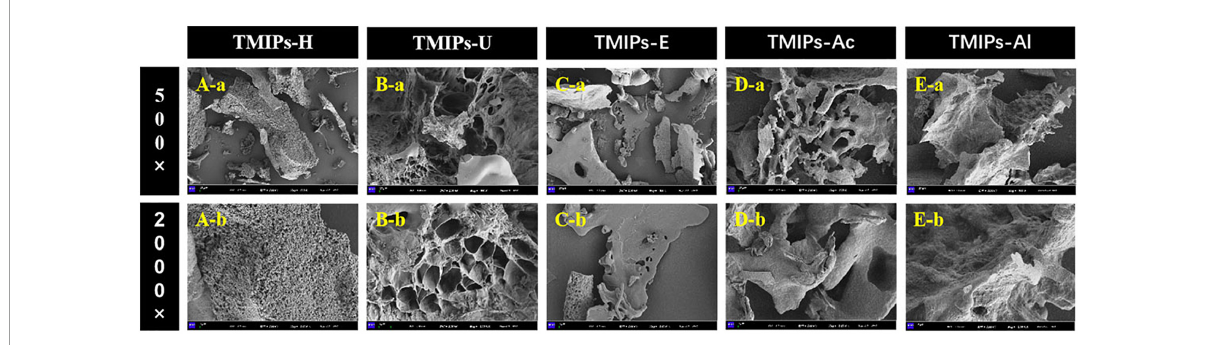
FIGURE5 Scanning electron microscopy (SEM) micrographs of TMIPs. (A) TMIPS-H; (B) TMIPS-U; (C) TMIPS-E; (D) TMIPS-Ac; (E) TMIPS-Al; a. 500 × magnification; b. 2,000 ×